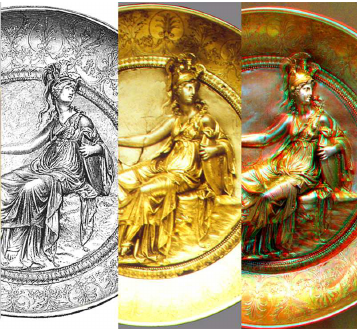
Figure 9. The comparison of a manual drawing with a 2D photography and a color anaglyphs presentation of a part of the